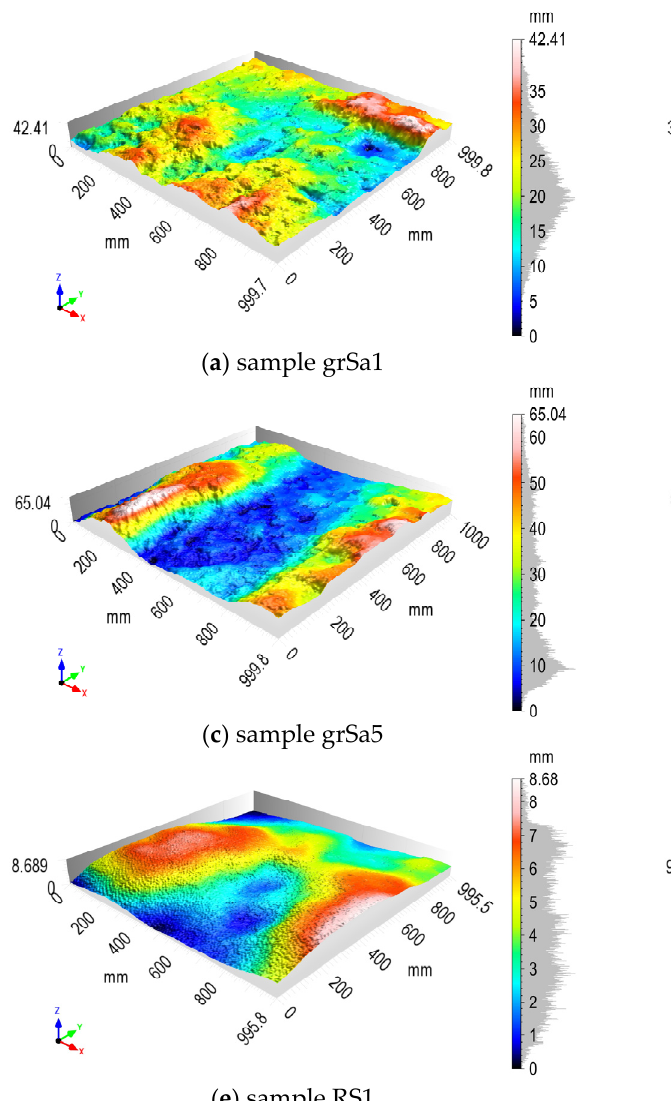
Figure 12. Results of diaphragm wall surface processing for chosen samples: ( a – d ) from anthropogenic soil; ( e – h ) from medium sand.